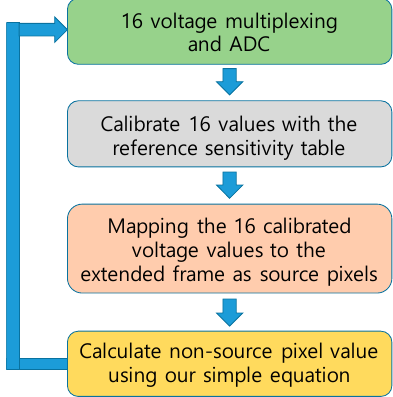
Figure 14. Insole data acquisition and visualization scheme.